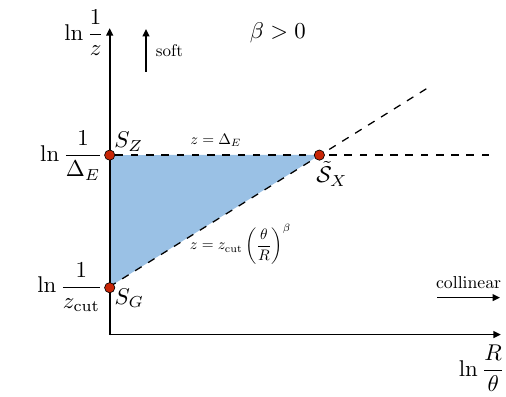
Figure 4 . Lund diagram for the jet energy drop ∆ E for iterative soft drop grooming, with ∆ E (cid:28) z cut (cid:28) 1 . At LL accuracy, emissions in the shaded triangle are vetoed. The relevant modes in SCET correspond to the red dots at the corners of the triangle, with their power counting summarized in table